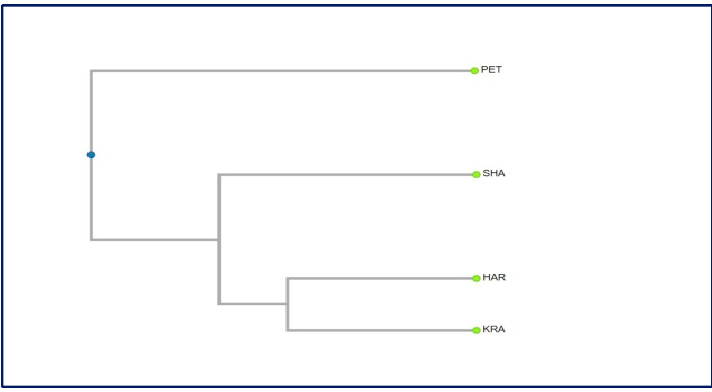
Figure 8. Dendrogram based on the genetic distances among the studied populations. As in P. apennina [68] and P. heterochroma [70], the level of genetic variability in Prim- ula veris was high both at species and at population levels (Table 3). Therefore, it can be concluded that the high genetic diversity is common for Primula species. It correlates with their outcrossing nature, which is a prerequisite for high level of genetic diversity within populations and lower differentiation among populations